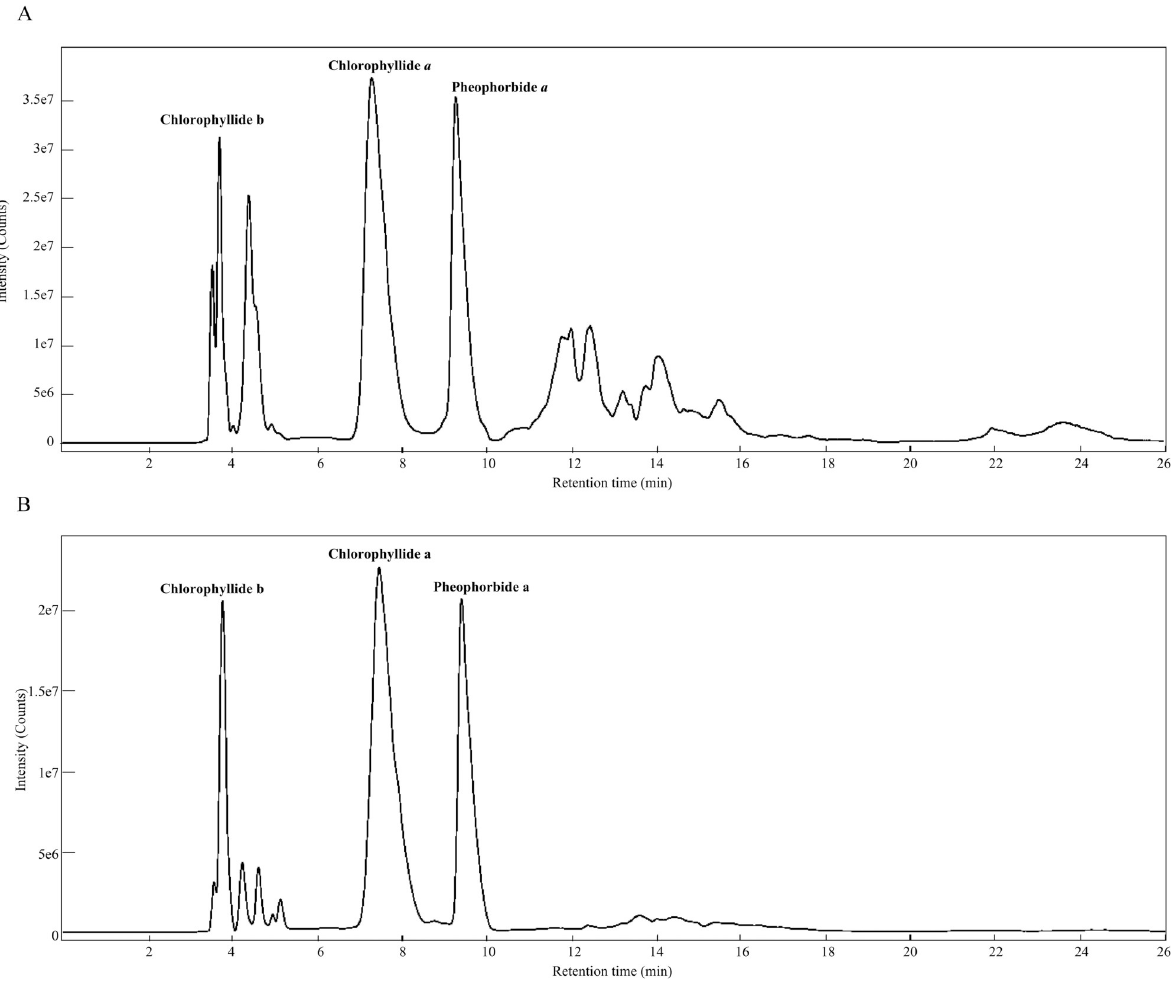
Fig 1. The UPLC-Q-TOF/MS data of (A) crude chlorophyllides and (B) purified